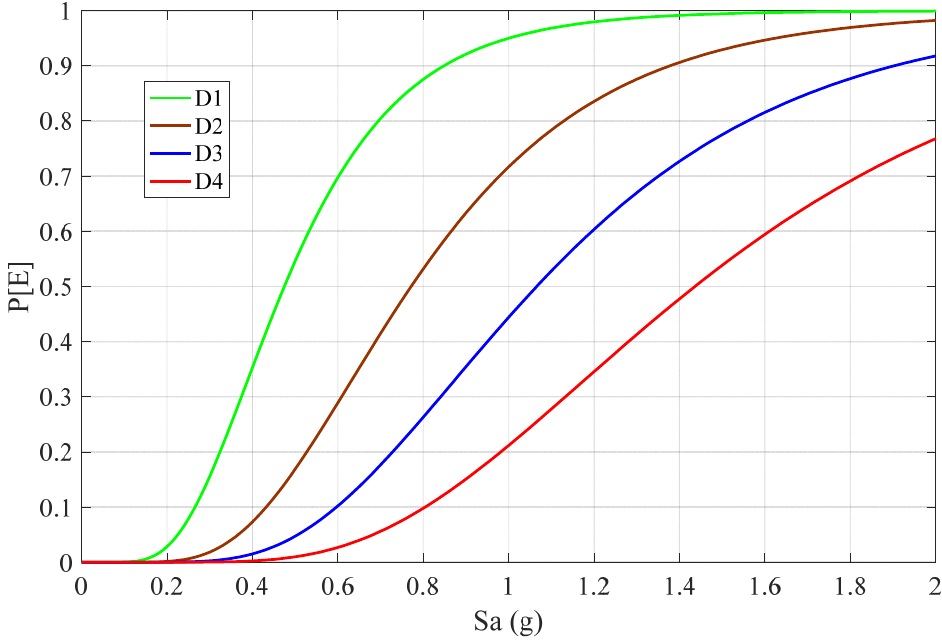
Figure 9. Foreshock and mainshock fragility functions for low-rise SMRF buildings.